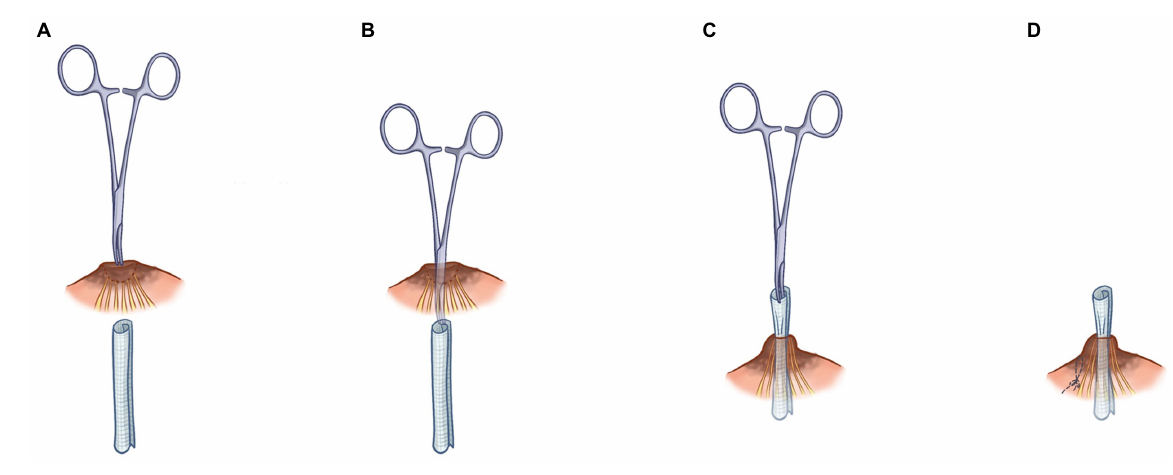
FIGURE 2 Step-by-step description of nipple depression valgus operation with traction. First place the mosquito forceps at the center of the sunken nipple (A) , then pull the mosquito forceps out of the center of the nipple (B) , then pull the oil yarn out of the center of the nipple (C) , and finally sew on the side of the nipple (D) .